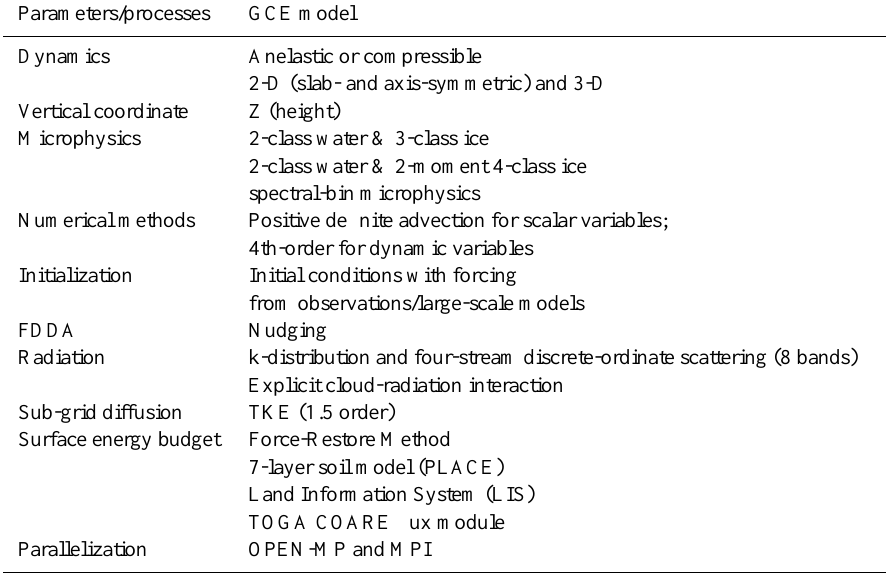
Table 1. Major characteristics of the Goddard Cumulus Ensemble (GCE)